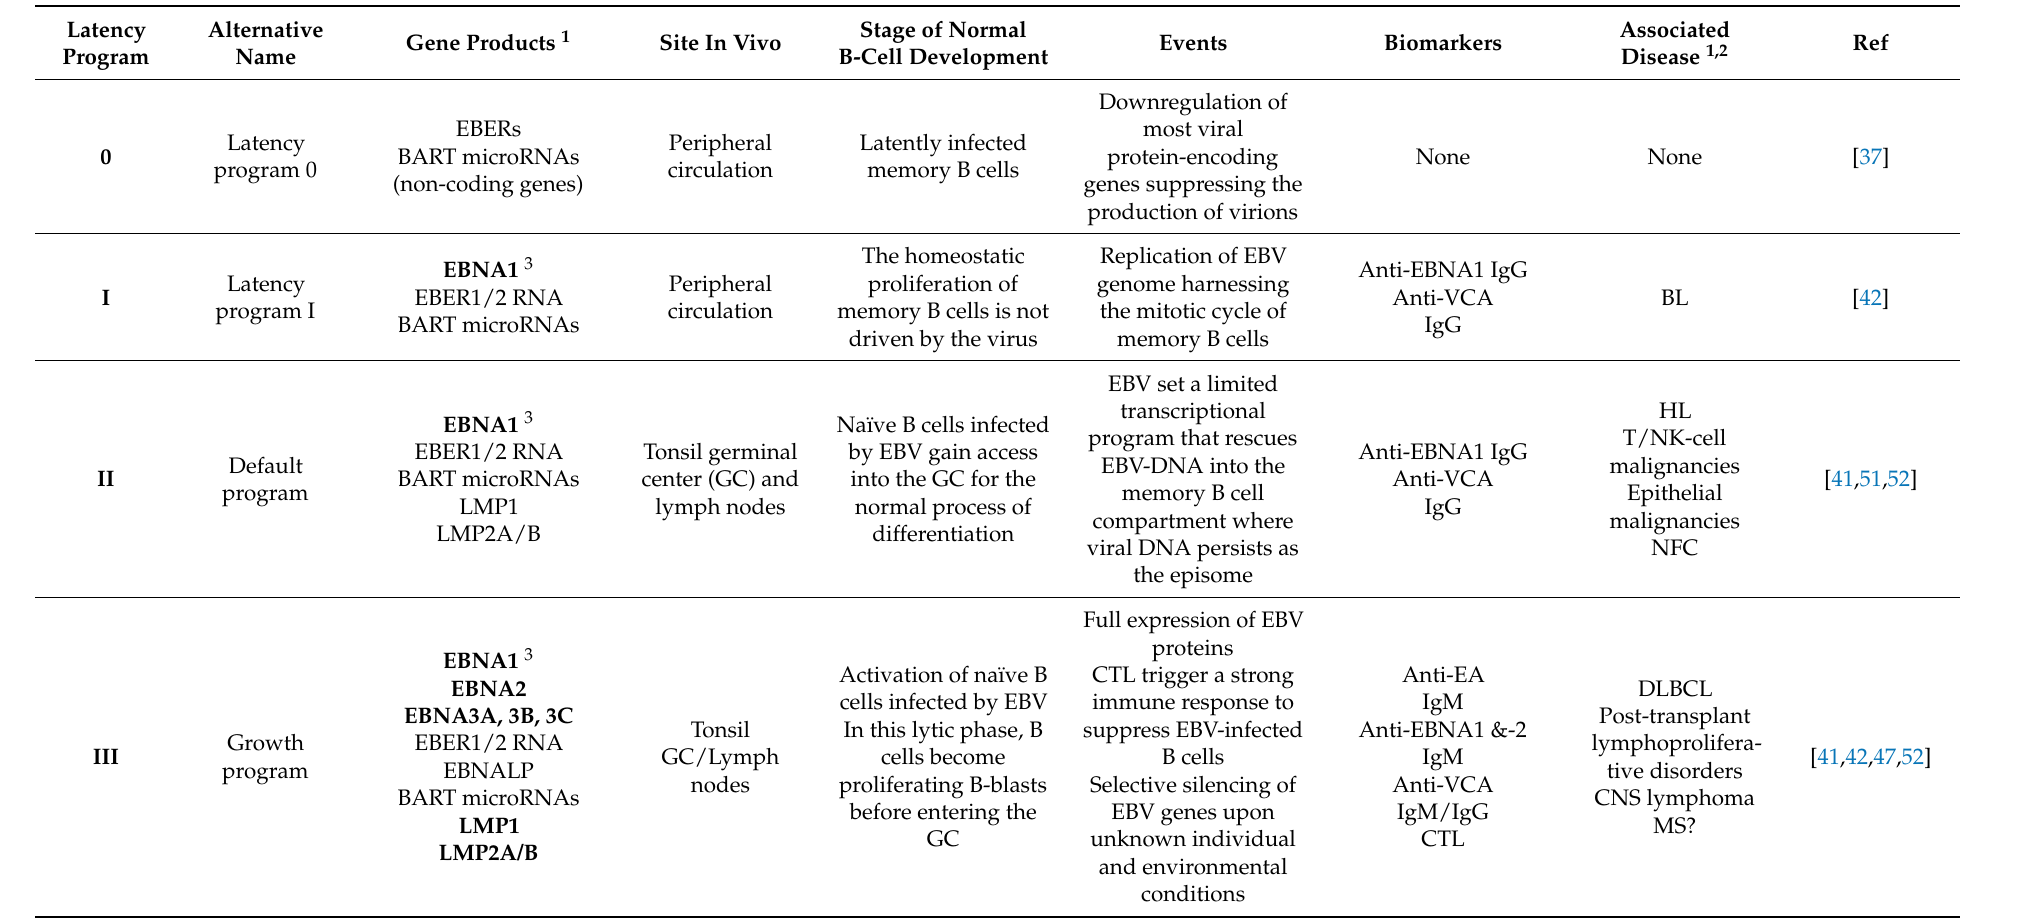
Table 1. Specific patterns of EBV gene expression during the latent phase of infection and their association with malignancies and